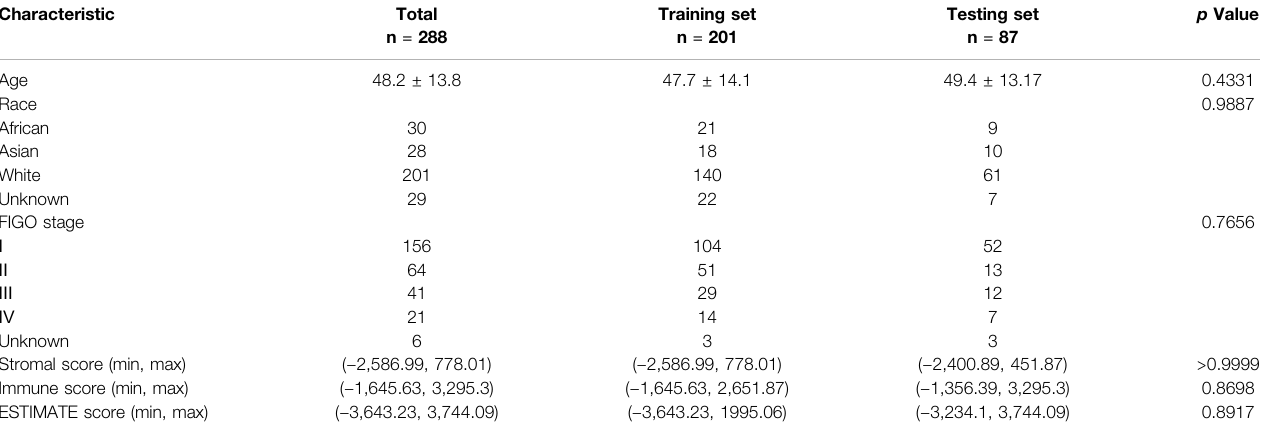
FIGO stage, International Federation of Gynecology and Obstetrics